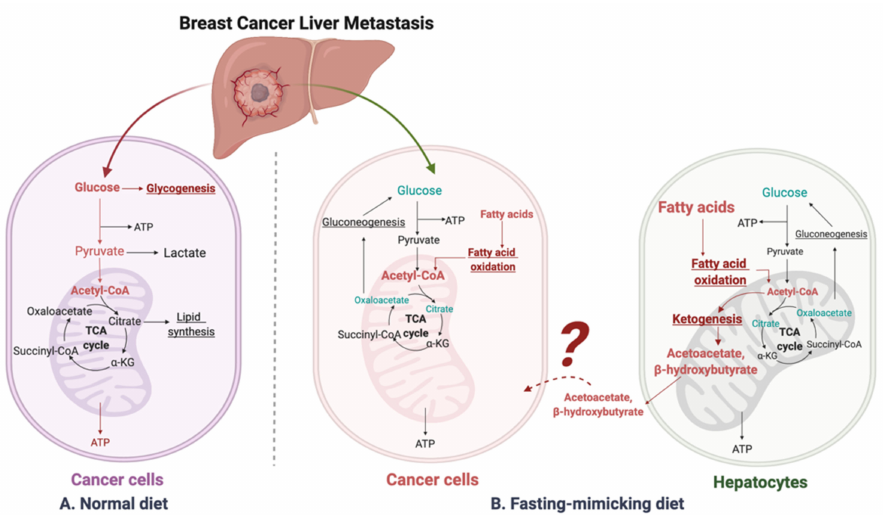
Figure 1. Suggested liver metastatic cancer metabolism in normal diet or fasting-mimicking diet. In the presence of glucose, the breast cancer cells metastasized to the liver mainly go through glycolysis to produce pyruvate, which is converted to acetyl-CoA via oxidative decarboxylation. Acetyl-CoA enters the tricarboxylic acid cycle (TCA cycle) and generates adenosine-3-phosphate (ATP) for cell survival and proliferation. Excessive glucose can be stored as glycogen for further usage. When glucose is limited (under a fasting-mimicking diet), the cancer cells switch to acquire ATP by fatty acid oxidation. The fatty acid oxidation is also highly activated in peripheral hepatocytes, where abundant acetyl-CoA feeds into ketogenesis and produces a large amount of acetoacetate and β - hydroxybutyrate. The liver does not use ketone bodies for energy because it lacks the necessary enzyme thiophorase (beta ketoacyl-CoA transferase). The unclear part is how these released ketone bodies function on breast cancer